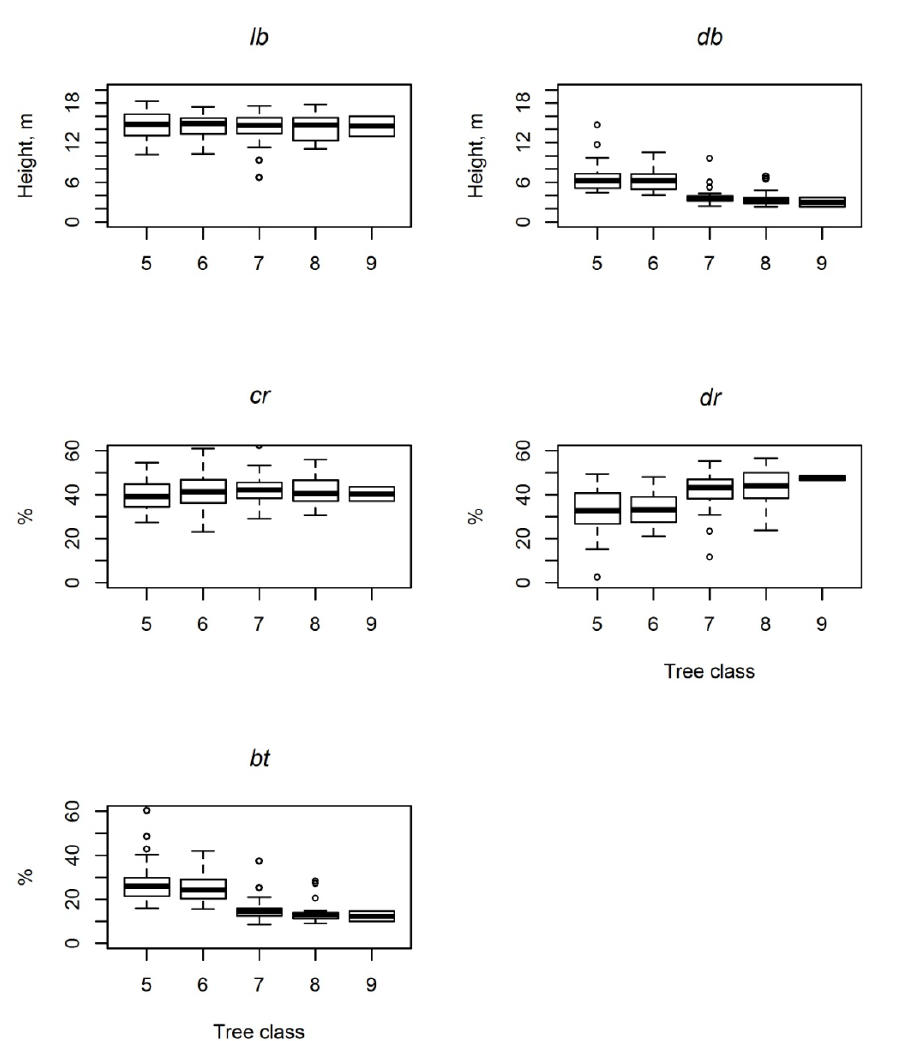
Figure 4. Boxplots of the various field-measured explanatory variables used to estimate